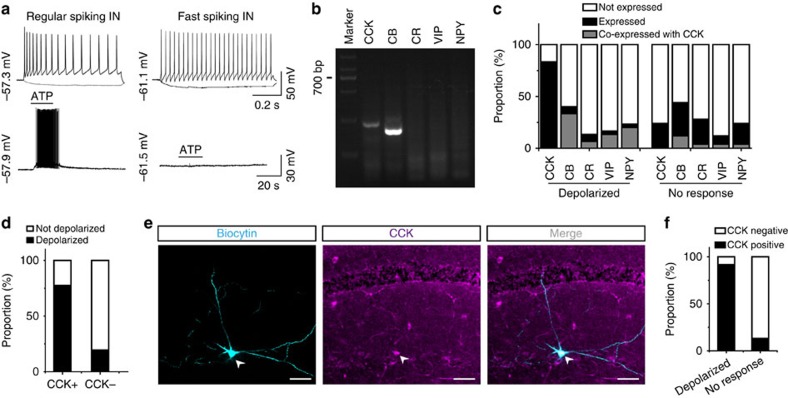
ATP-excited neurons are mainly CCK-positive interneurons.(a) Sample traces showing the AP discharge pattern of an ATP-responsive CCK interneuron (left) and ATP non-responsive fast-spiking interneuron (right). APs in upper traces were generated by injection of 100 pA depolarizing current. (b) Representative agarose gel electrophoresis results showing the expression of the interneuron markers CCK, CB, CR, VIP and NPY in an ATP-responsive interneuron. The final PCR product of CCK is 234 bp. (c) Summary data showing the proportion of interneuron marker expression in neurons responsive or unresponsive to ATP. Black, expression of indicated markers; white, no markers; grey, markers co-expressed with CCK. (d) Summary data showing the proportion of CCK-containing interneurons responsive to ATP. ‘CCK+', neurons expressing CCK; ‘CCK−', neurons without expression. Black, neurons depolarized by ATP; white, neurons not affected. (e) Confocal images showing that a biocytin-filled interneuron (arrowhead) responding to ATP was CCK-positive. Scale bars, 50 μm. (f) Summary of immunostaining results showing the proportion of ATP-excited interneurons that were CCK-positive. Black, CCK expression; white, no CCK expression.